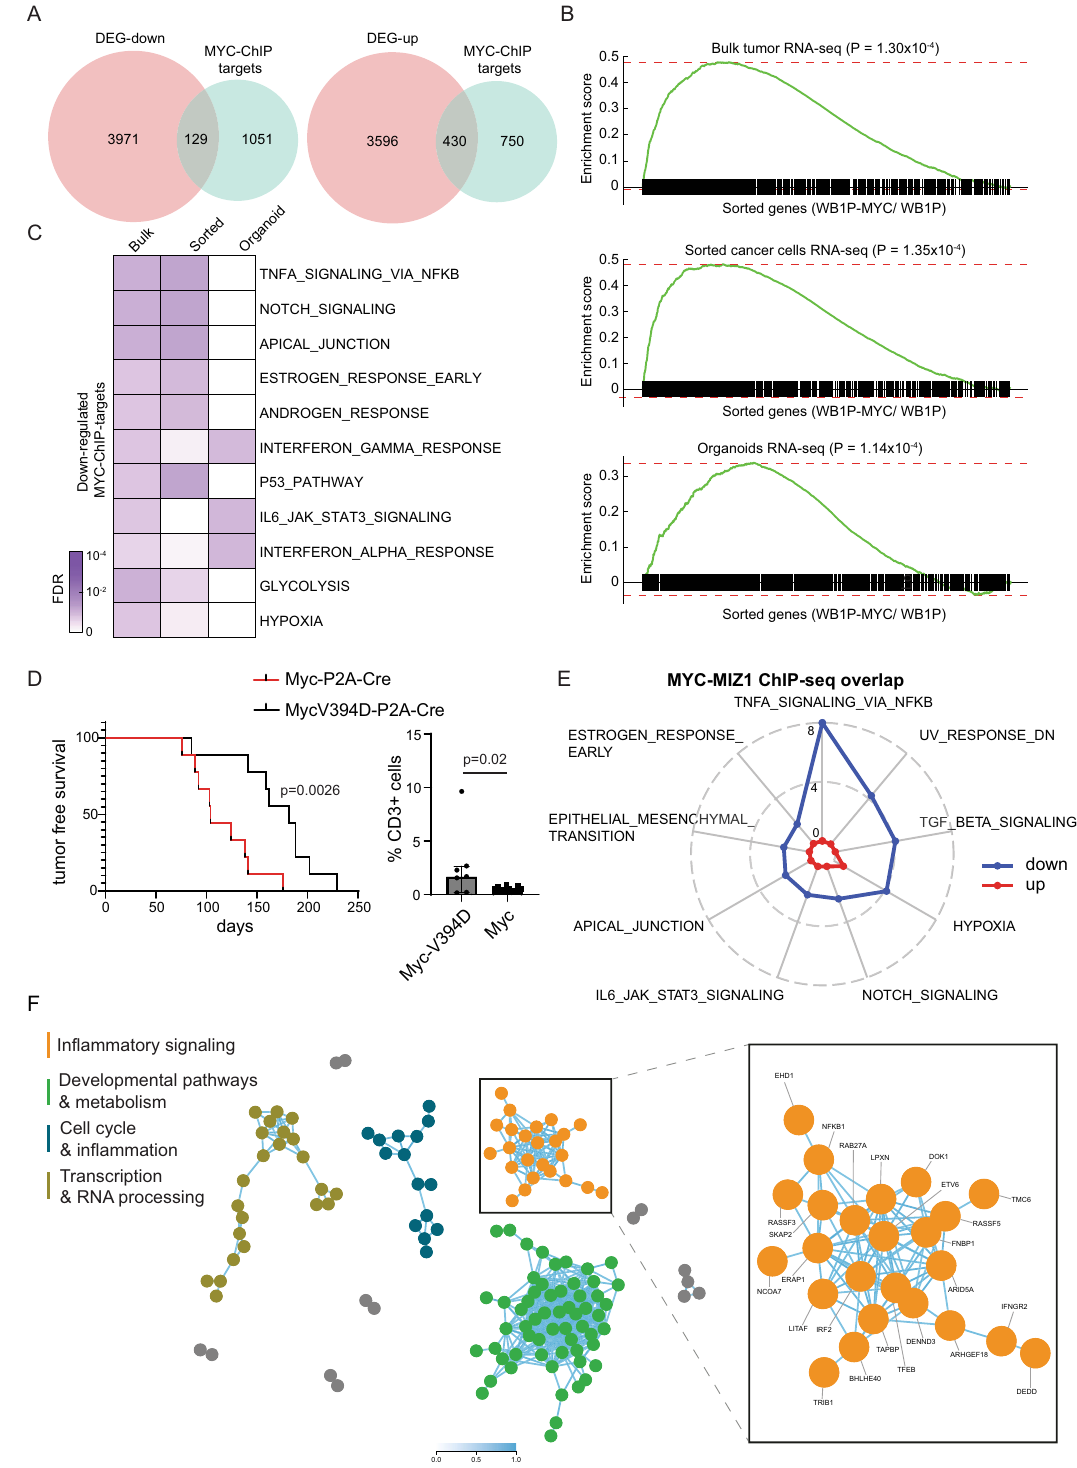
BRCA1/2 function results in activation of STING signaling and sub- single-agentICIdidnotshowef fi cacyinTNBC,neo-adjuvantpaclitaxel-